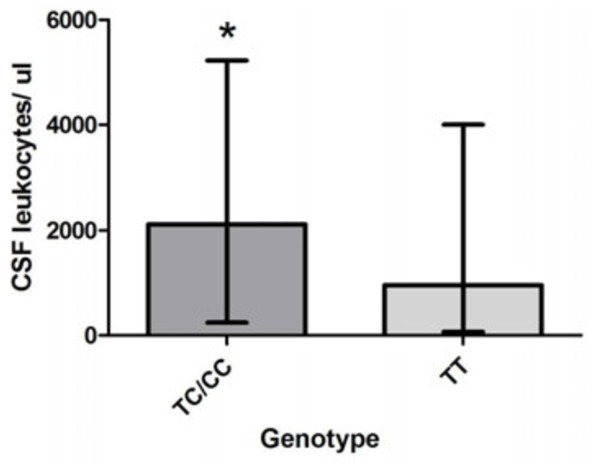
(A) Comparison of CSF leukocytes per μL inTLR9 -1237 TC/CC carriers versus wild type (WT) carriers. Carriers of TLR9 -1237 TC/CC had significantly higher CSF leukocyte numbers compared to carriers of the TT WT (medians: 2117, interquartile range (IQR) 4987 versus 955, IQR 3938). Mann–Whitney U test, * p = 0.024. Abbreviatons: TLR: Toll-like receptor, SNP: single nucleotide polymorphism, CSF: cerebrospinal fluid, ul: microliter. (B) Comparison of CSF/blood glucose ratios in TLR9 -1237 TC/CC carriers versus WT carriers. Carriers of TLR9 -1237 TC/CC genotypes display significant lower ratios compared to carriers of the TT WT (medians: 0.20, IQR 0.4 versus 0.35, IQR 0.5). Mann–Whitney U test, * p = 0.017. Abbreviatons: TLR: Toll-like receptor, SNP: single nucleotide polymorphism, CSF: cerebrospinal fluid, ul: microliter. (C) Comparison of CSF leukocytes per μL in TLR9 +2848 AA mutant carriers versus GG/GA carriers. Carriers of the TLR9 AA mutant display significantly higher CSF leukocyte levels compared to GG/GA carriers (medians: 1907, IQR 5221 versus 891, IQR 3952). Mann–Whitney U test, ** p = 0.0067. Abbreviatons: TLR: Toll-like receptor, SNP: single nucleotide polymorphism, CSF: cerebrospinal fluid, ul: microliter.